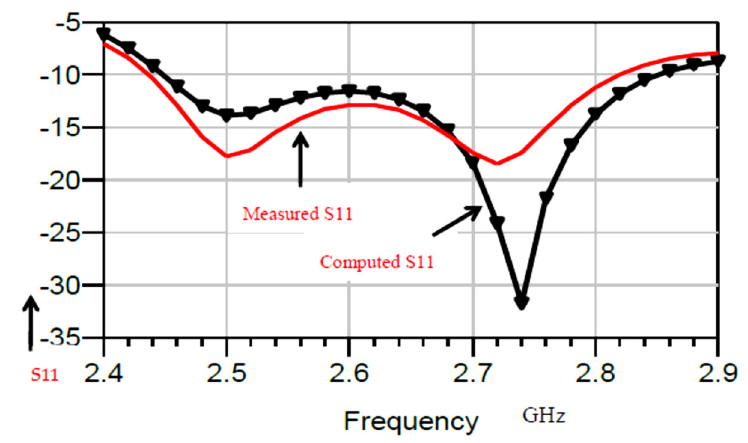
Figure 2. Computed and measured S11 of the metamaterial circular polarized antenna.